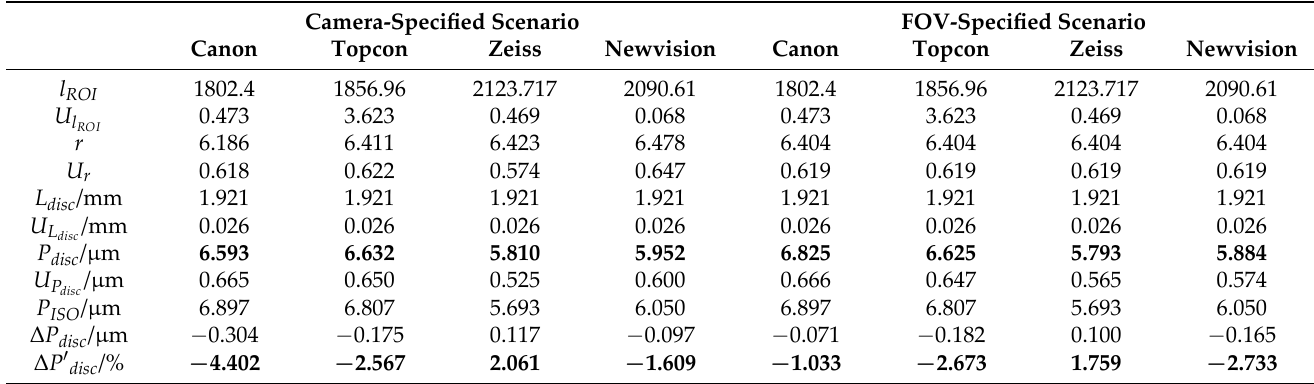
Table 5. Results of pixel pitch calibration in camera-specified scenario and FOV-specified scenario for four types of fundus cameras.